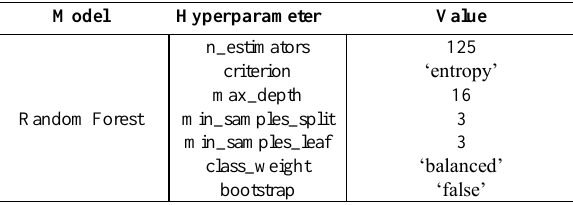
Table 5. Optimized hyperparameters for the RF method.